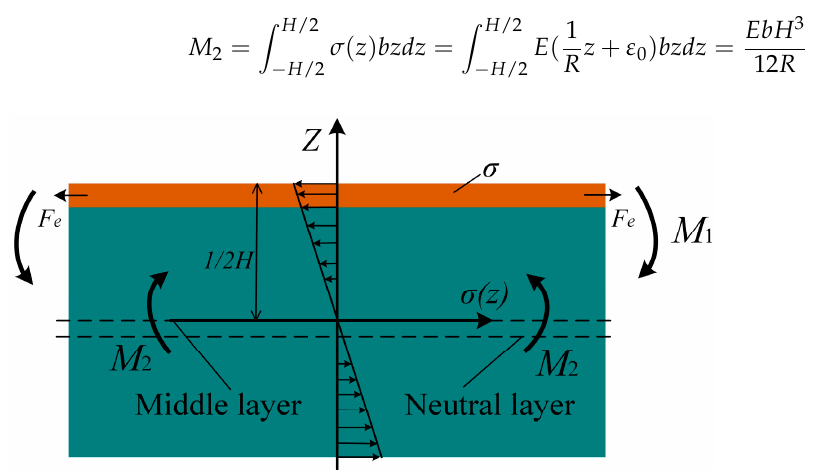
The equivalent bending moment M 2 is obtained by integral calculation of the bending stress inside distortional workpiece, as shown in Equation (7). The distribution of bending stress is shown in Figure 2: